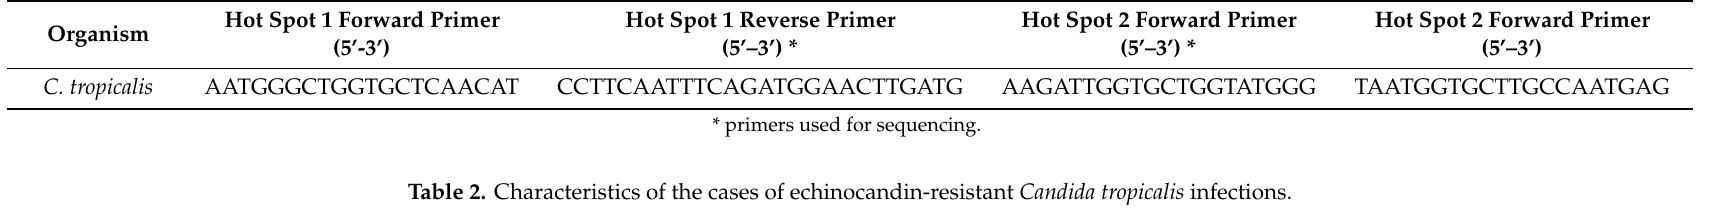
Table 1. Oligonucleotides used for FKS1 PCR and sequencing.